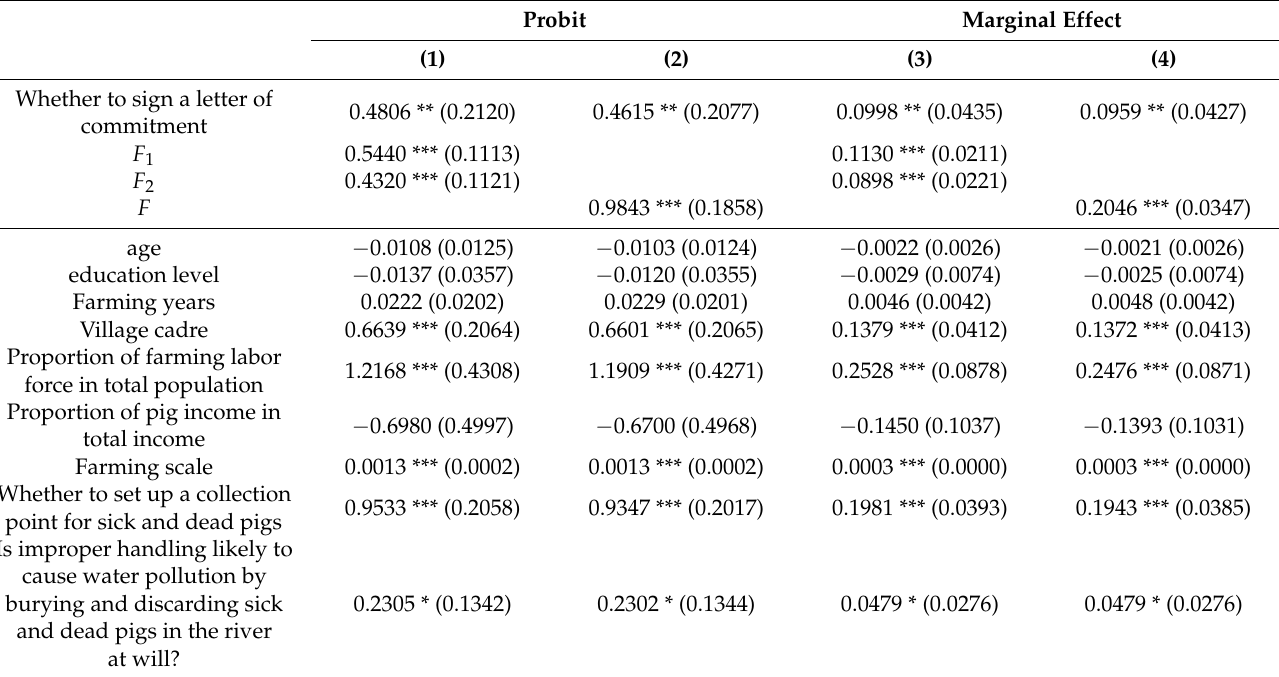
Table 4. The impact of whether to sign a letter of commitment and the reward and punishment mechanism on the behavior of farmers in adopting the waste recycling treatment of sick and dead